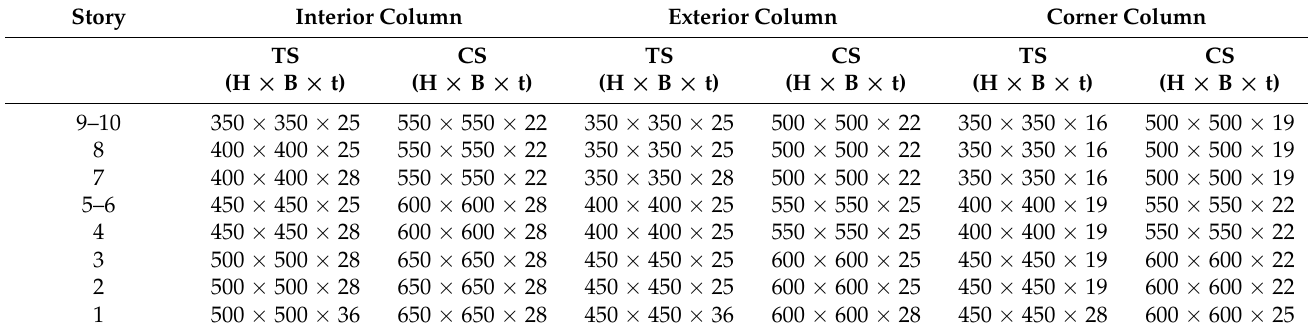
Table 2. Structural column dimensions